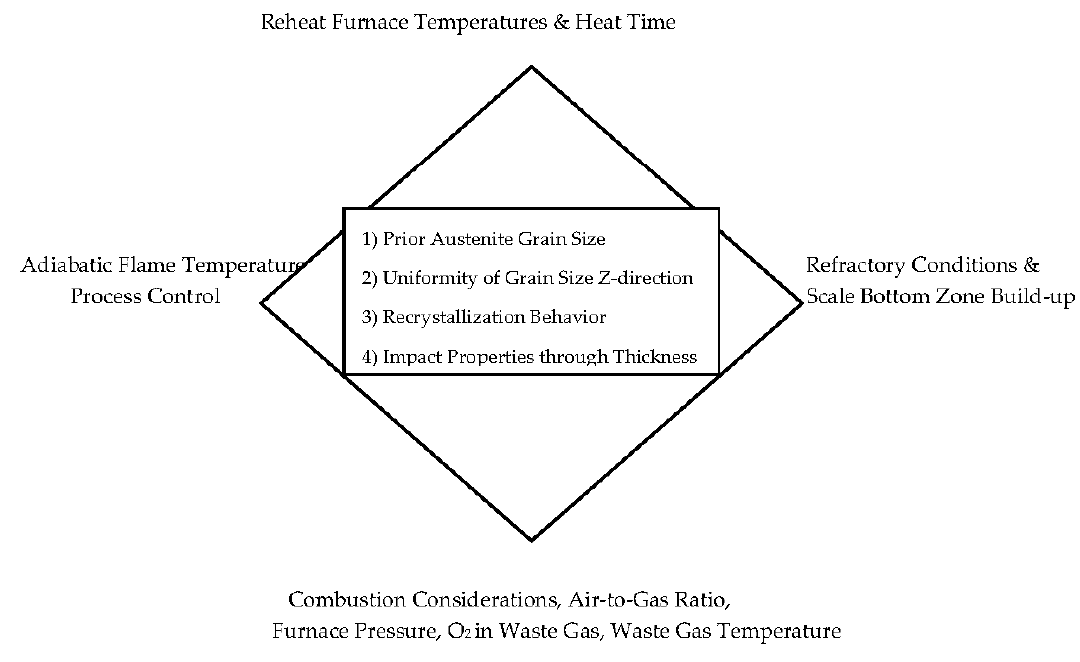
Figure 7. Physical and process metallurgical reheat furnace example (reproduced from [10], with permission from AIST, 2016).